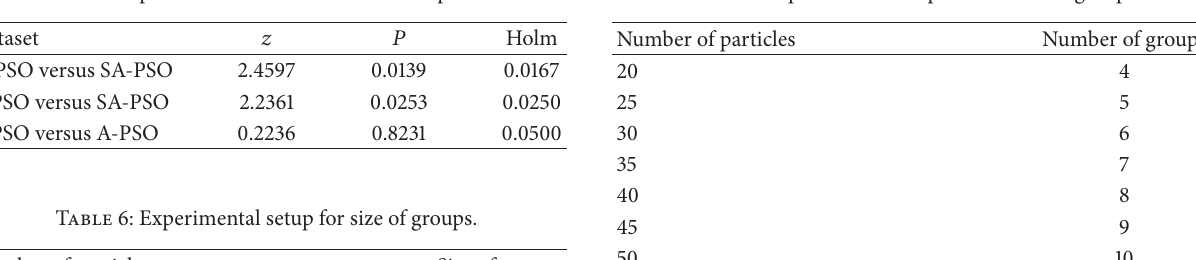
Table 5: Holm procedure on the results of the experiments.